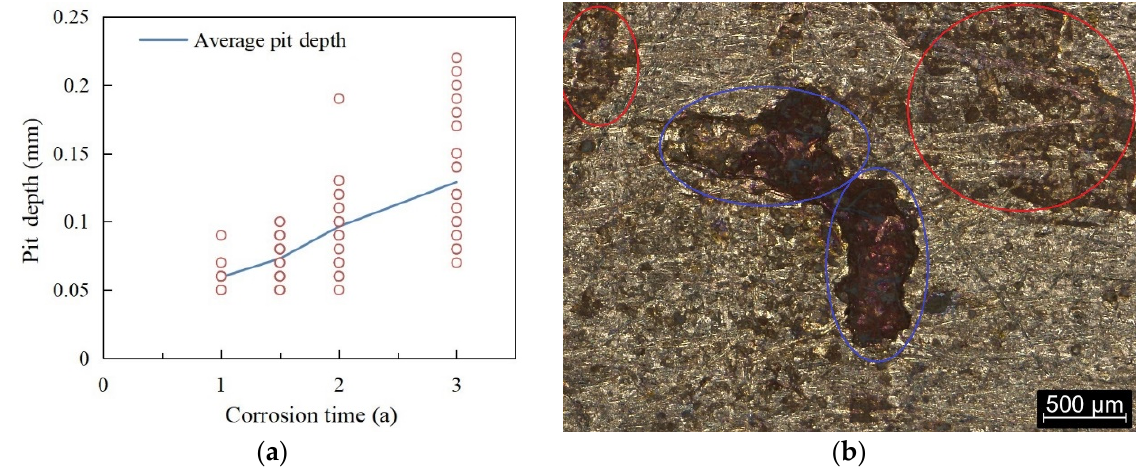
Figure 4. ( a ) The relationship between pit depth and corrosion time, ( b ) pit morphologies after 2 years.